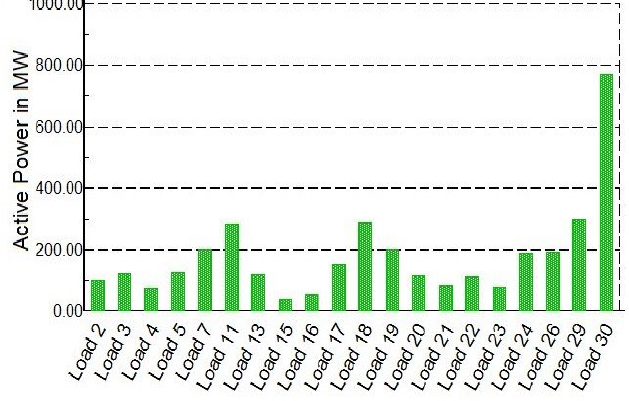
Fig. 8. Load active